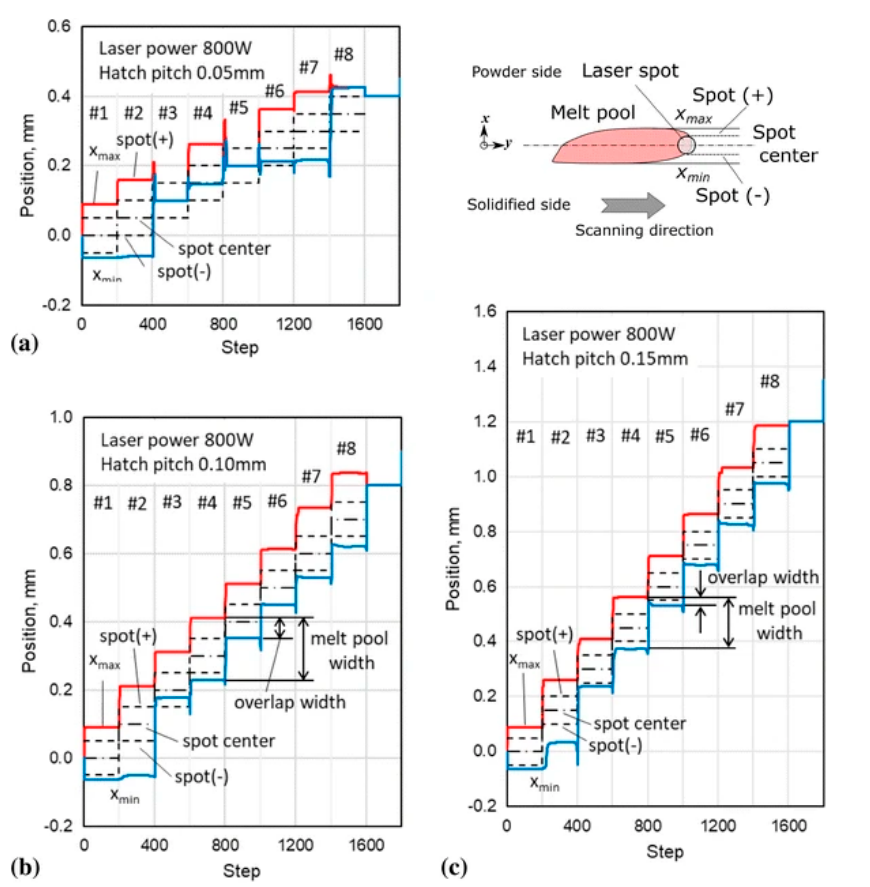
Figure 14. Positions of melt pool rim in x_direction (width) for hatch pitch of ( a ) 0.05 mm, ( b ) 0.10 mm, and ( c ) 0.15 mm. Reproduced with permission from[2] Springer Nature, 2017.